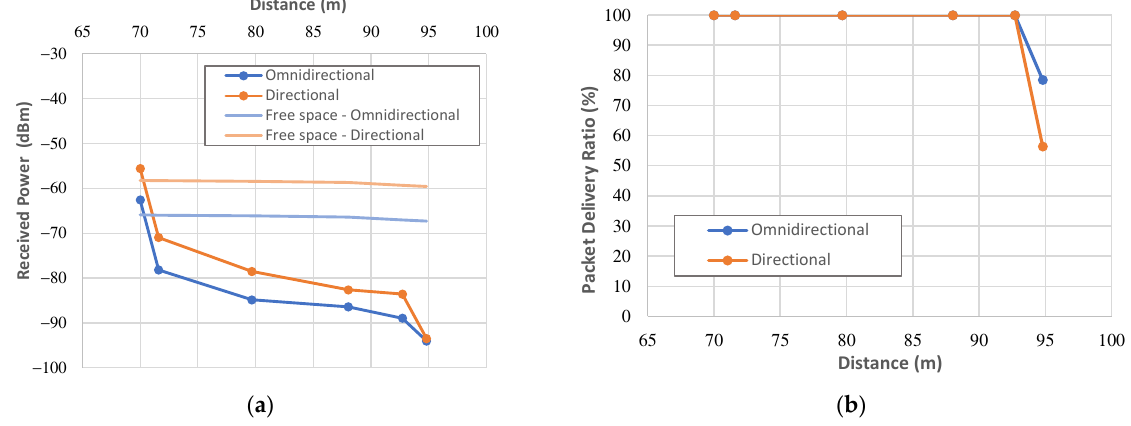
Figure 9. Measurements results of XBee for location 2: ( a ) average RSSI; ( b ) PDR.